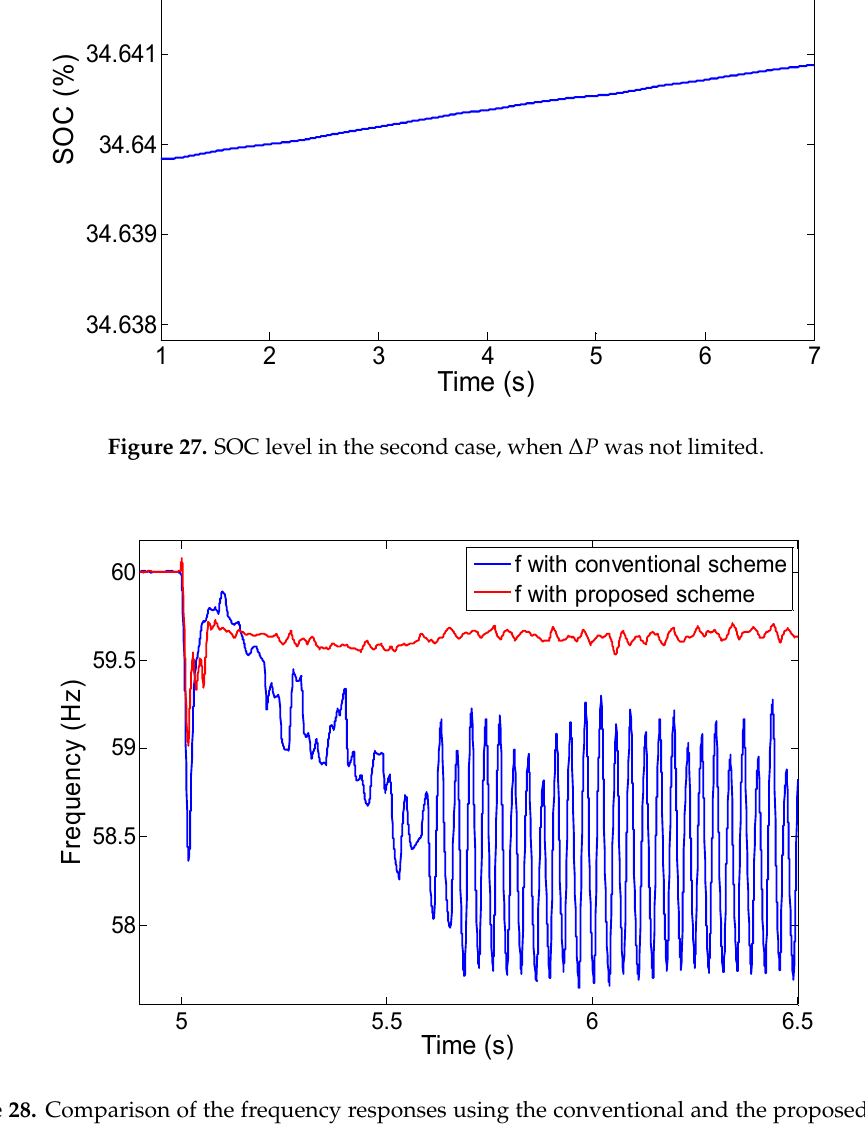
Figure 27. SOC level in the second case, when ∆(cid:1842) was not limited.